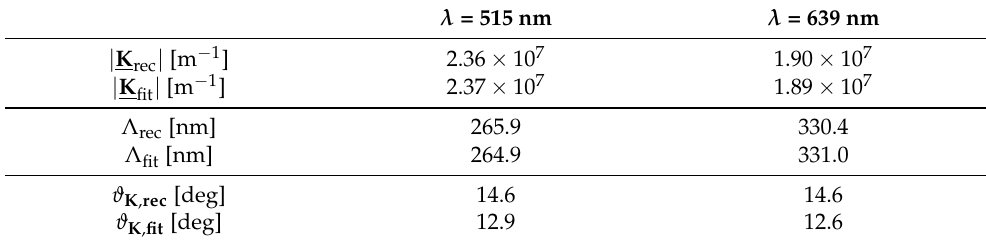
Table 3. Fit parameters of Bragg’s